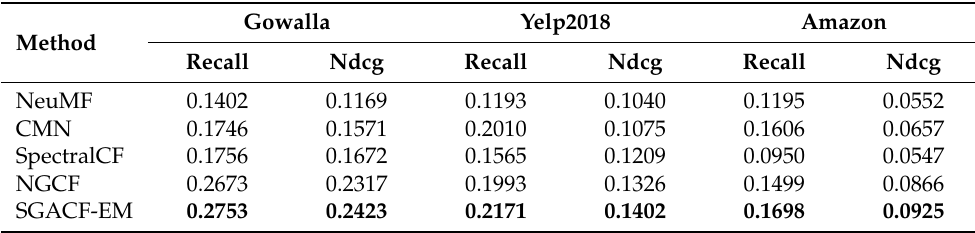
Table 2. Performance comparison of SGACF with other comparative